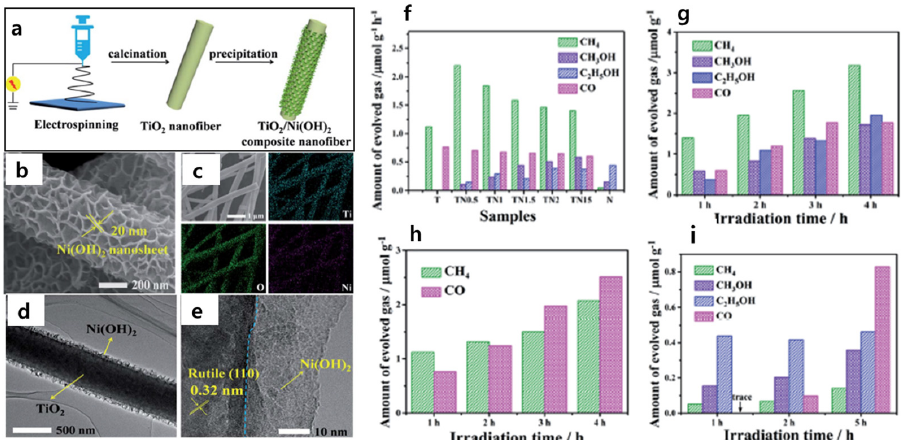
Figure 9. (a) Synthesis illustration of hierarchical TiO 2 /Ni(OH) 2 hybrid composite, (b) SEM, (c) energy ‐ dispersive X ‐ ray spectroscopy (EDX) mapping, (d ‐ e) TEM images of TiO 2 /Ni(OH) 2 with 15 wt% Ni(OH) 2 loading and (f ‐ i) the photocatalytic CO 2 reduction behavior of various samples, reprinted with permission from